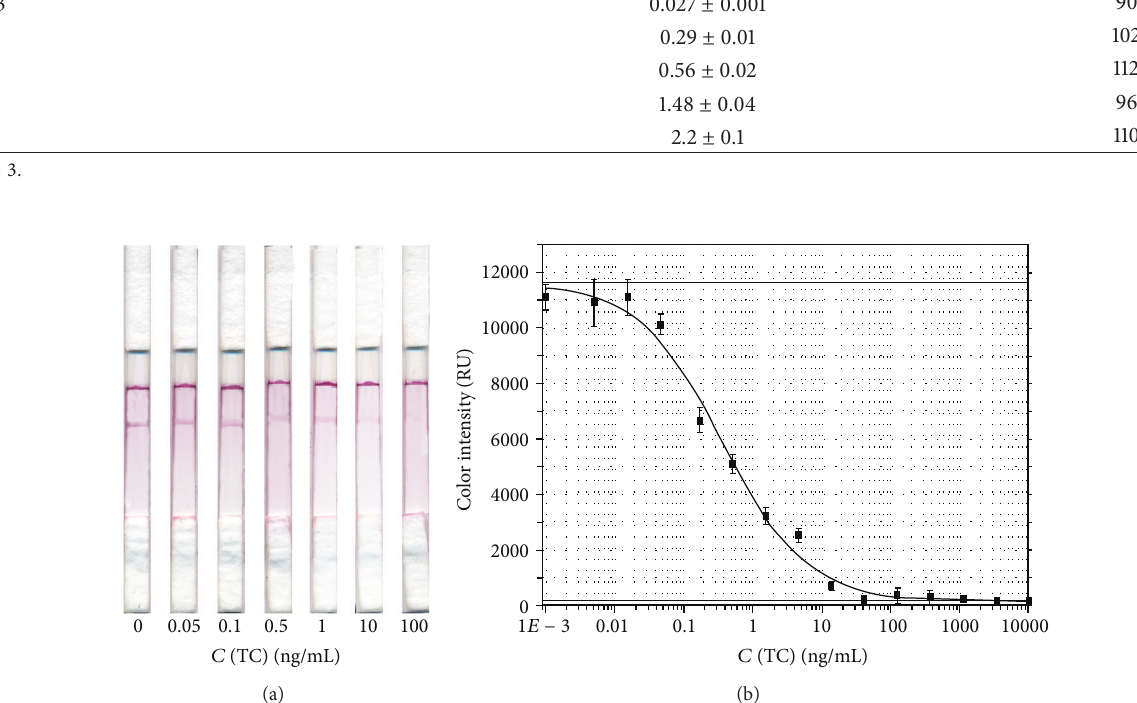
Figure 10: Test strips (a) and calibration curve, 𝑛 = 3 (b) for immunochromatographic determination of the TC in milk